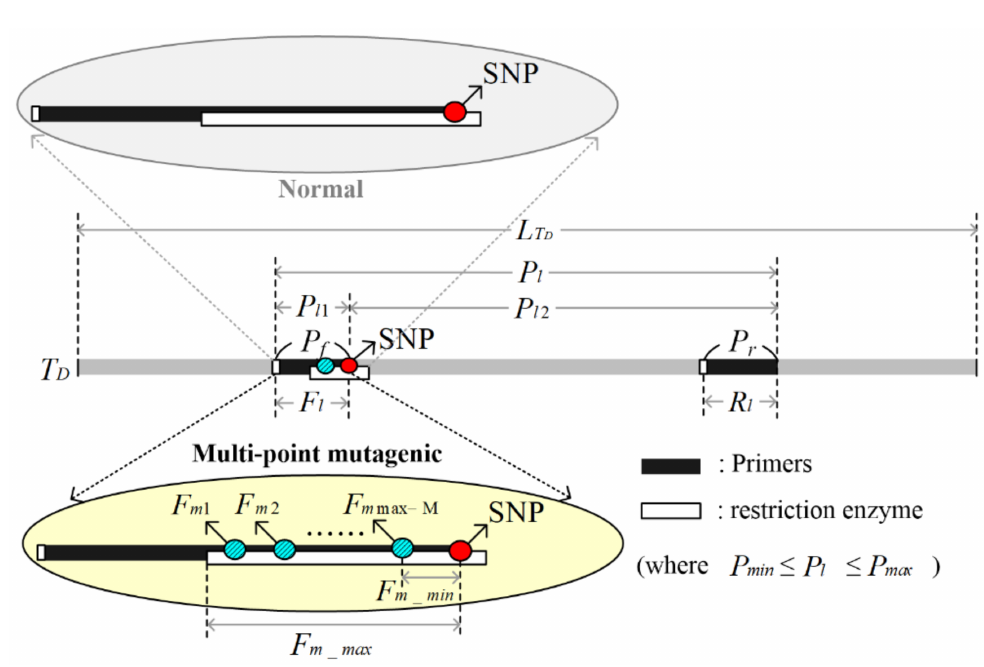
Figure 1. Conceptual diagram of multi-point mutagenic primer